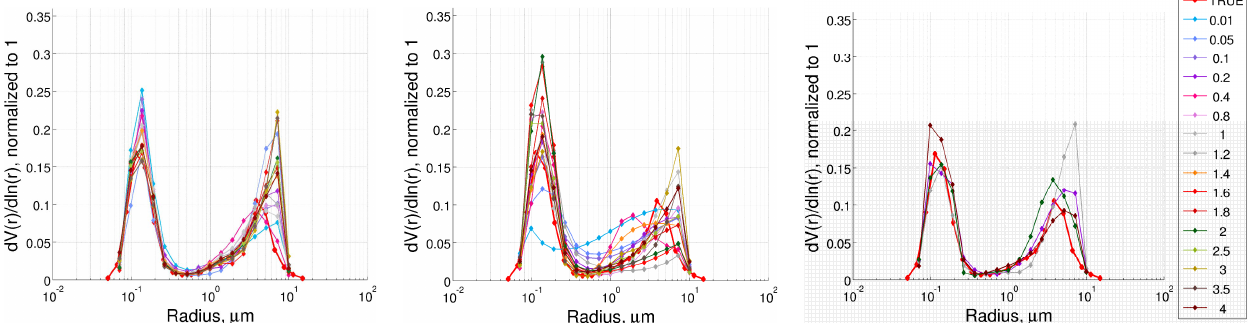
Fig. 9. Retrieval of biomass burning size distribution over Mongu for 16 different aerosol loadings from τ (0.44µm)=0.01 to 4.0: (left panel) single- pixel retrieval with no noise added; (center panel) single-pixel retrieval, with the random noise added; (right panel) multi-pixel retrieval, with the random noise added.